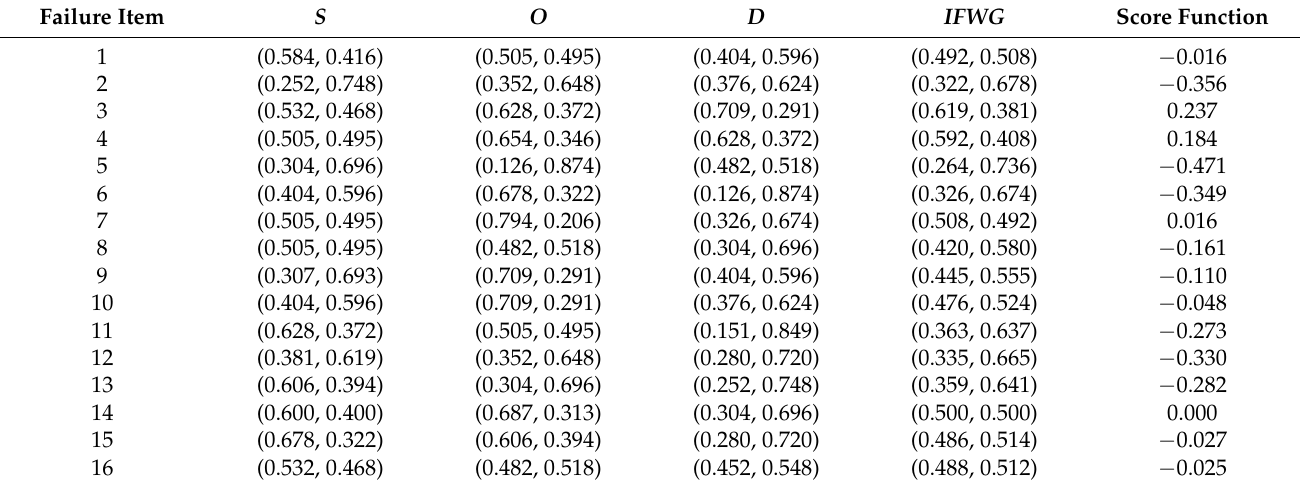
Table 7. The results of the intuitionistic fuzzy weighted geometric ( IFWG ) values.